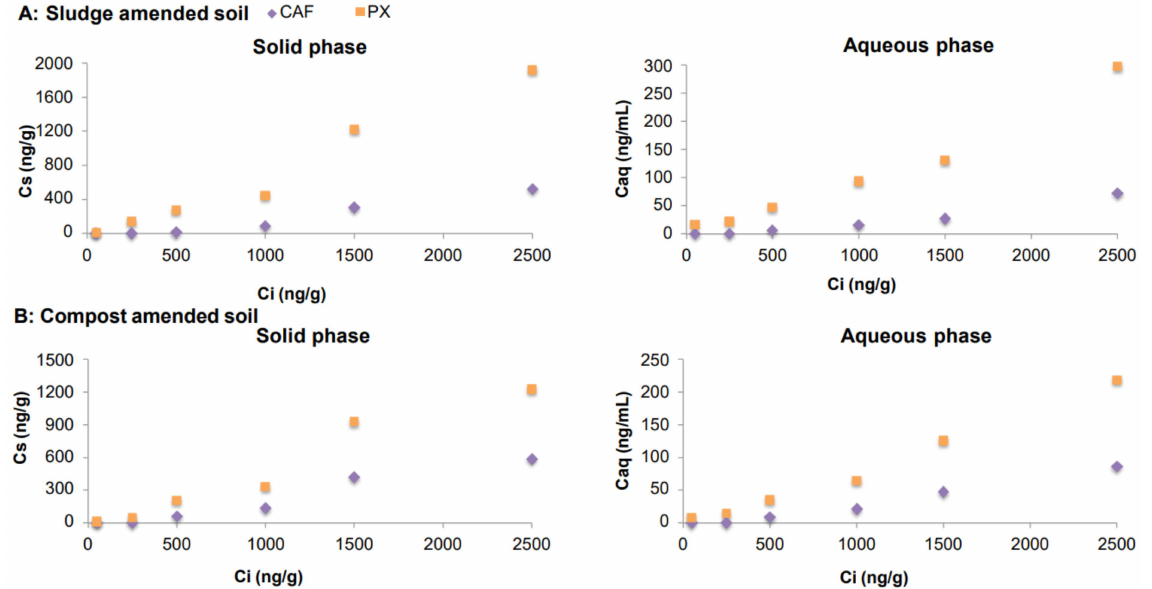
Figure 3. Concentrations of CAF and its metabolite in soil samples amended with spiked sewage sludge ( A ) and compost ( B